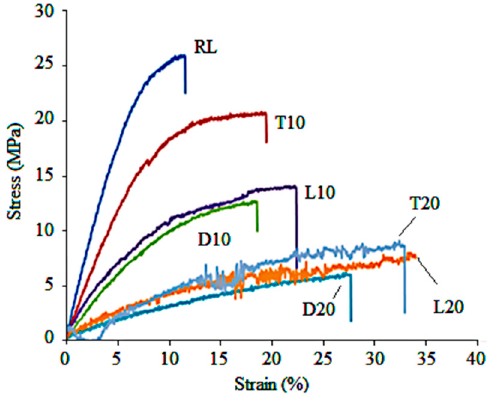
Figure 3. Stress-strain curves of OMRL films.